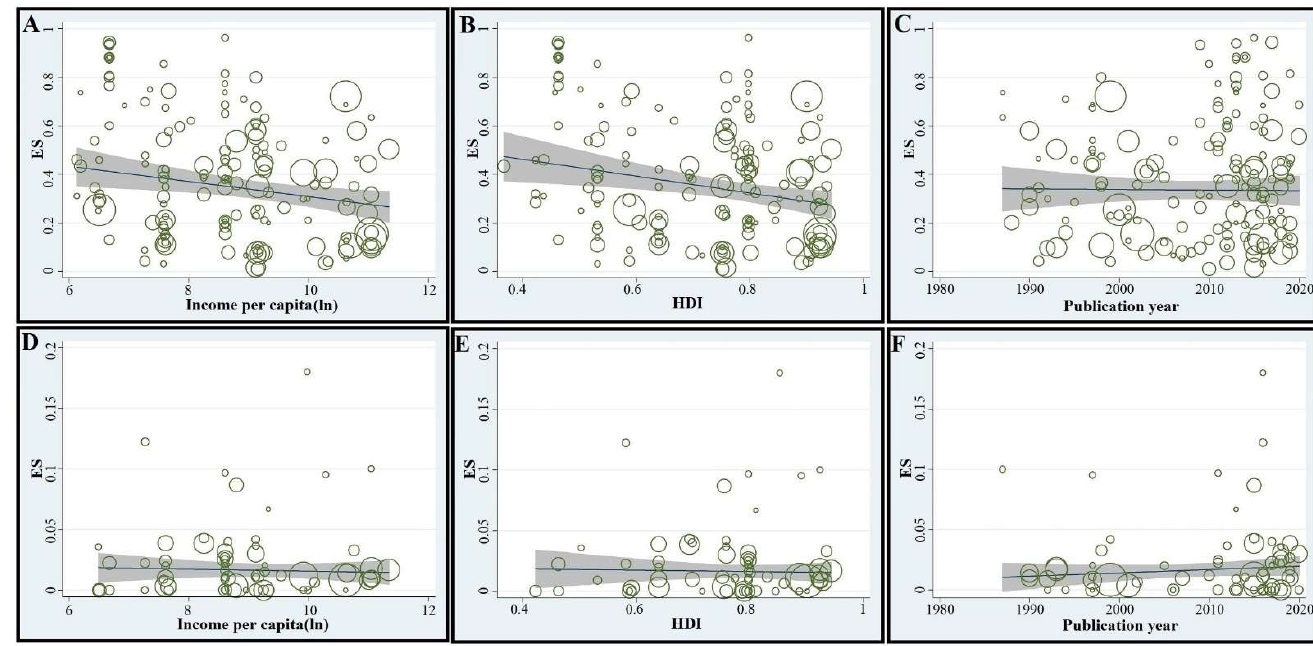
Figure 2. Meta-regression analyses of the seroprevalence rates of latent and acute T. gondii infections (LT and AT, respectively) in HIV + people. For LT, there was a statistically significant downward trend in prevalence in countries with higher income levels or higher human development index (HDI), and an upward trend (statistically insignificant) from 1980 to 2020 ( A – C , respectively). For AT, there was a downward trend (statistically insignificant) in seroprevalence in countries with higher income levels or higher HDIs, and an upward trend (statistically insignificant) from 1980 to 2020. ES: estimated seroprevalence ( D – F ).